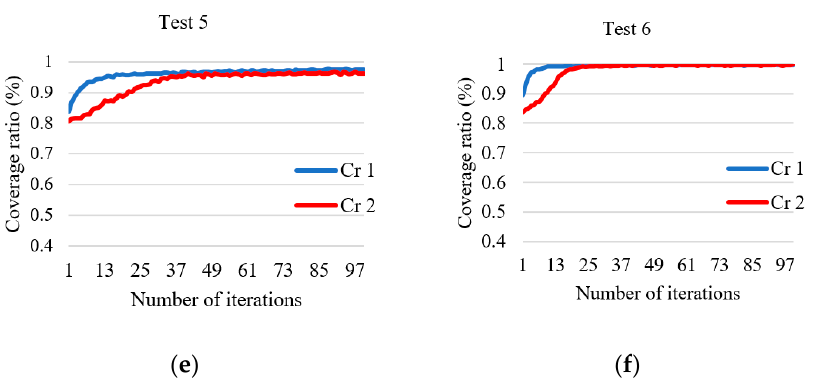
Figure 12. The relationship between the coverage ratio and the number of iterations of the proposed algorithm in the six tests. Figures ( a – f ) represent Tests 1–6, respectively.